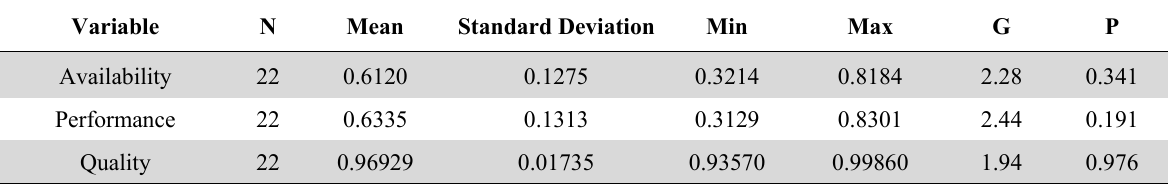
Outlier Test (Grubbs' Test)